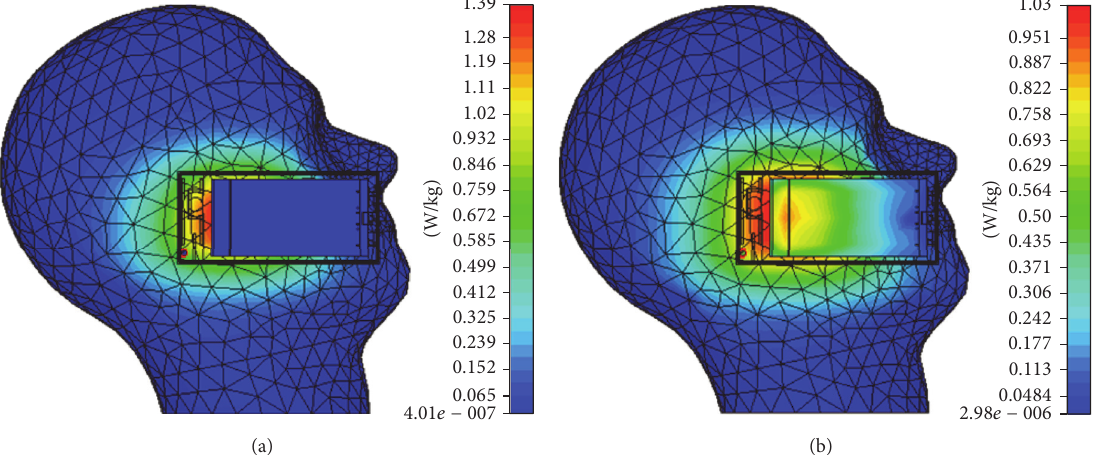
Figure 13: SAR distribution at 790 MHz: (a) average 1-g and (b) average 10-g.